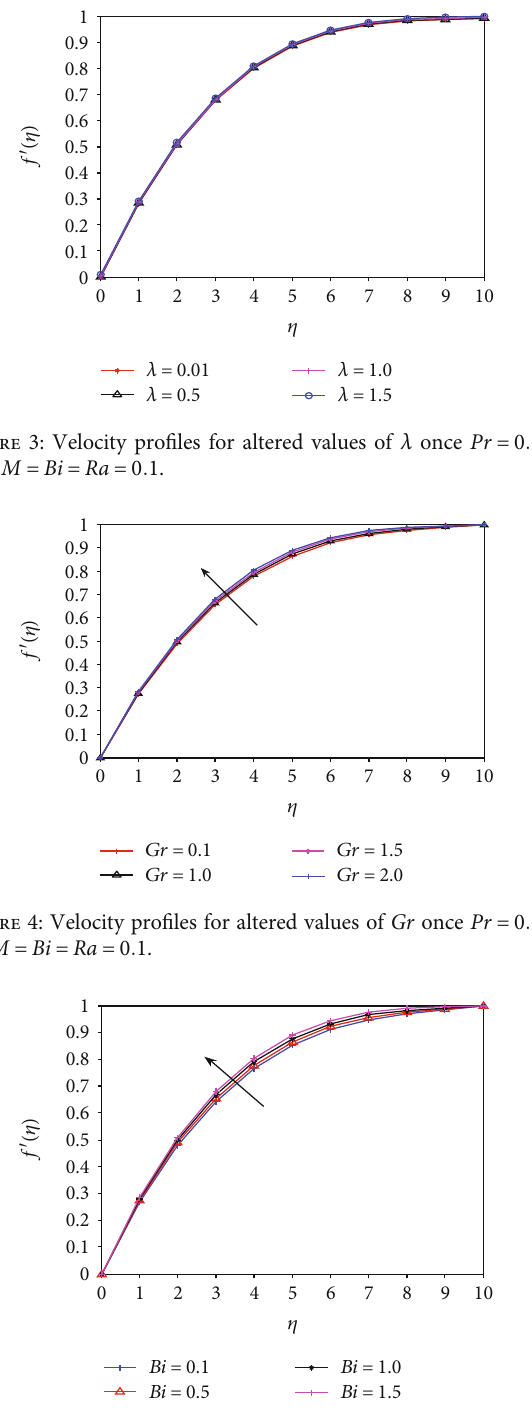
Figure 5: Velocity pro fi les for altered values of Bi once Pr = 0 : 72 , Gr = λ = M = Ra = Bi = 0 : 1 .